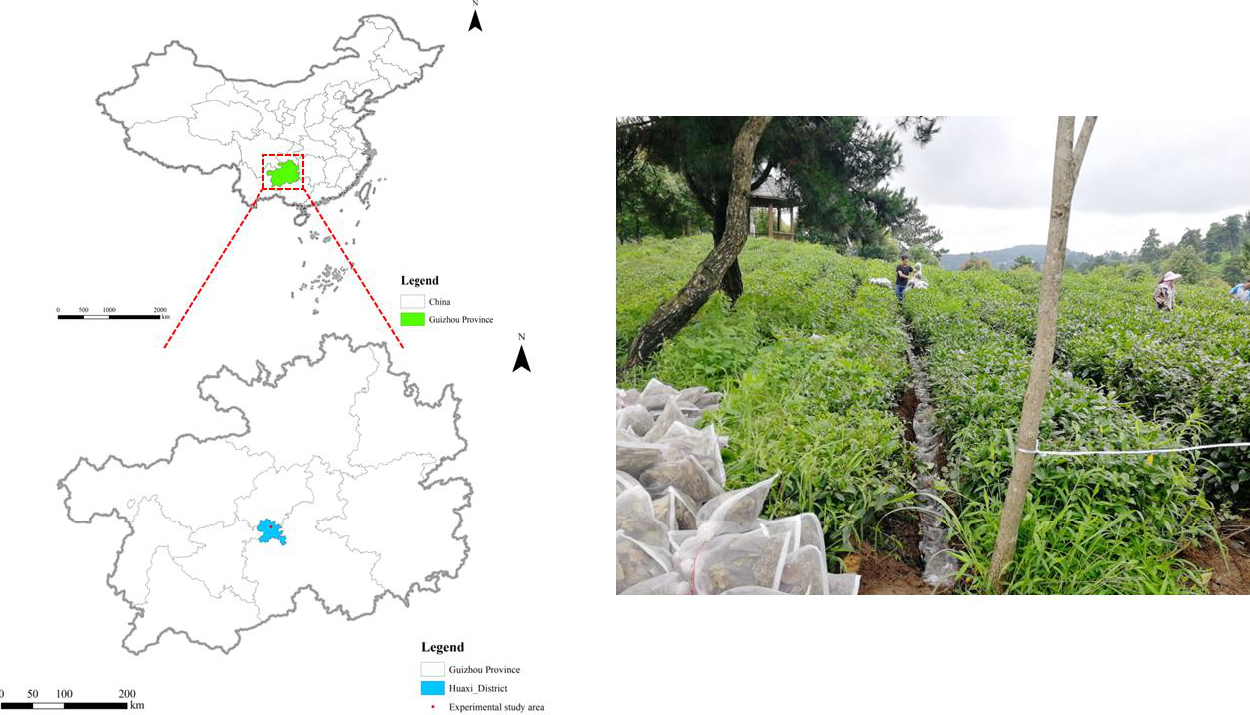
Figure 1. Experimental study area. Table 1. Basic properties of nutrients in leaf litter for